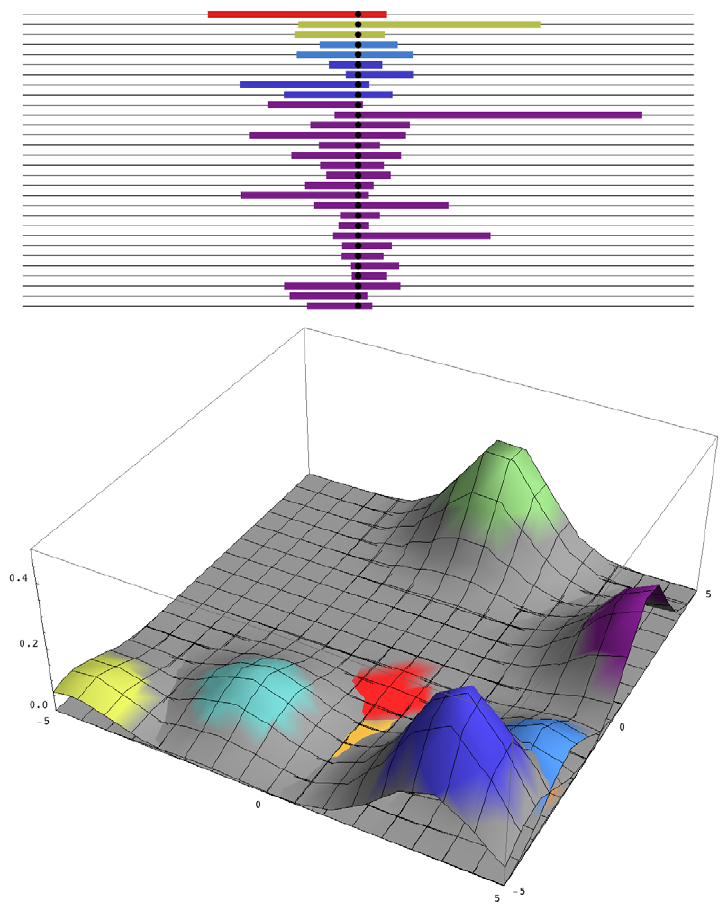
Figure 1. Patterns of diversity across the genome and in space. Top: A sample of 30 genomes, taken immediately after completion of a selective sweep, contains five distinct haplotypes. The horizontal axis represents the genome, with the selected site at the centre, and the unique block of haplotype carried by each independent mutation is indicated by the coloured segment. Over time, these segments will recombine with eachother, so that the region of strong linkage disequilibrium will shrink, without altering the region of reduced diversity. Bottom: A snapshot of the two-dimensional spatial distribution during the process of fixation. The nine commonest alleles are shown, which together make up 93% of the total diversity in the population. Colours correspond to those above. How many independent mutations contribute to adaptation depends only on the number of favourable mutations that enter in every generation, 2N m . In this example, 2N m =2; simulations with smaller 2N m show contributions from correspondingly fewer